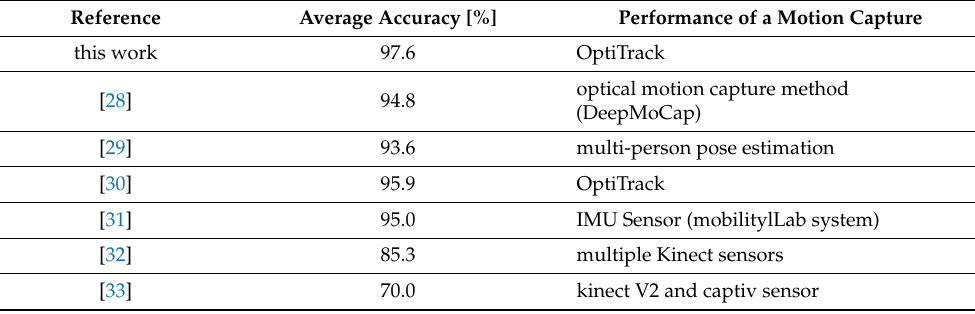
Table 4. Comparison for accuracy of proposed system and